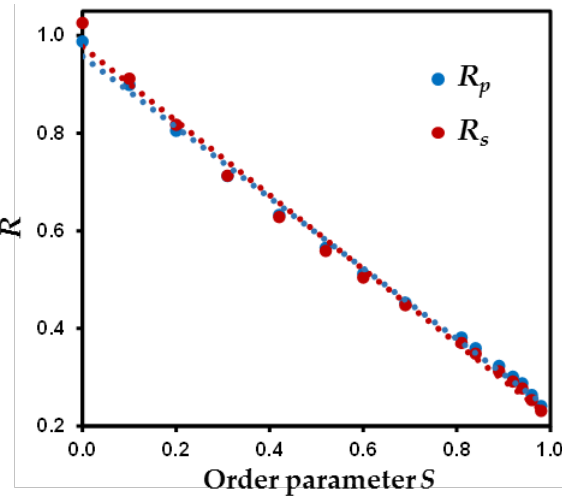
Figure 7. Evolution of ratios between mean chord length between the z and xy directions for both the solid and pore phases ( R s and R p , respectively) as a function the order parameter S .